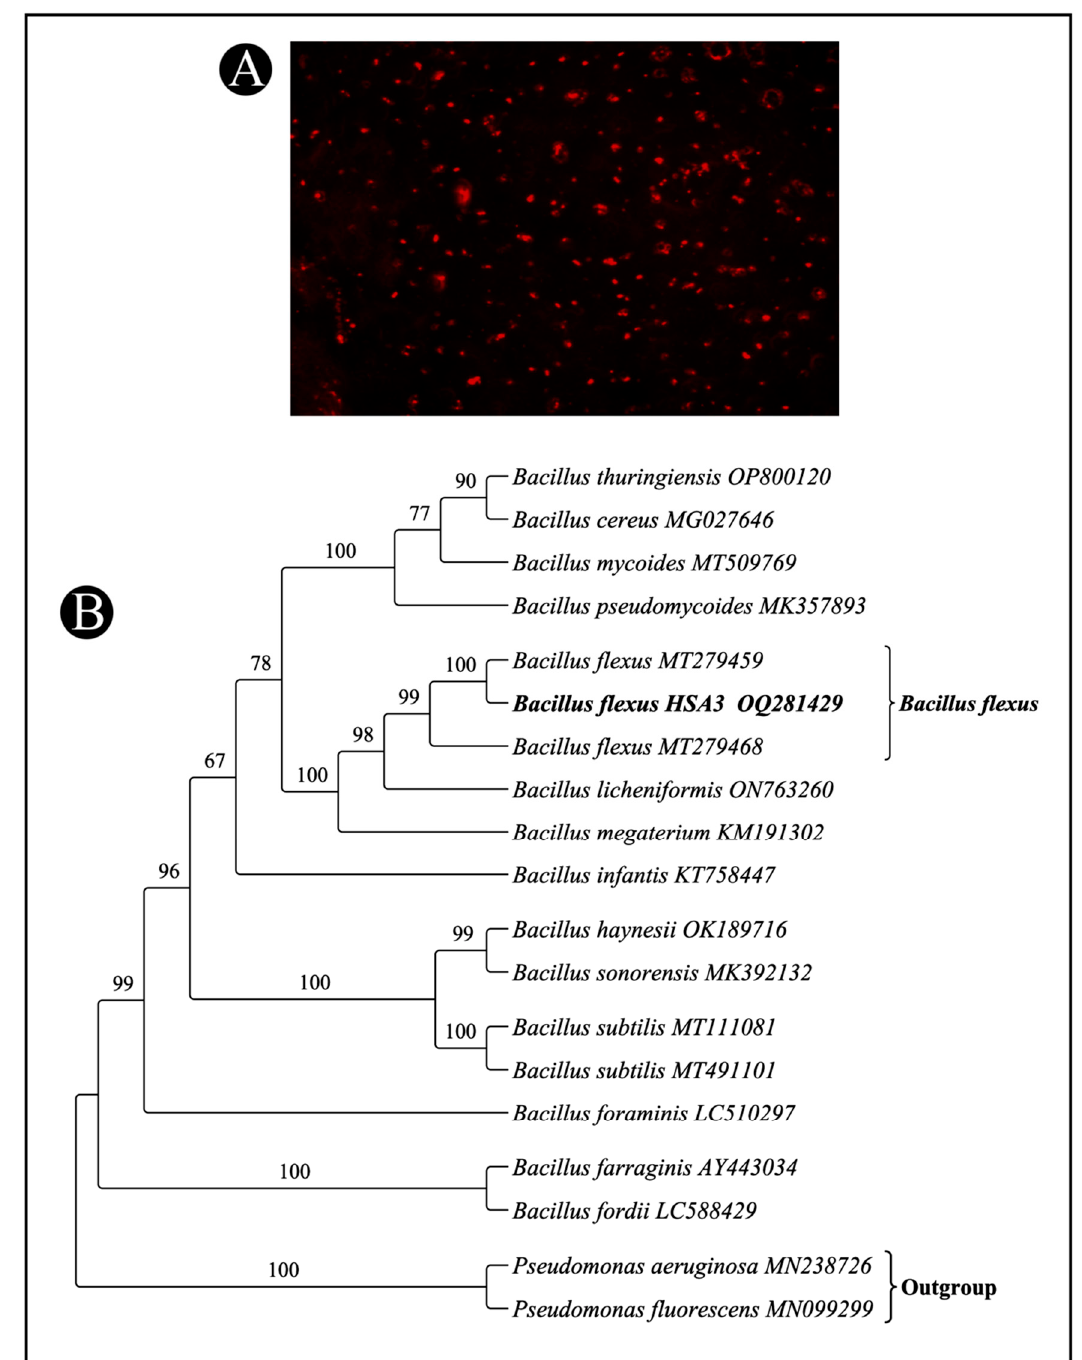
Figure 1. Screening of promising bacterial isolates for PHB production. ( A ) Staining of HSA3 isolates with Nile blue dye as observed under fluorescence microscope ( B ) Phylogenetic tree based on 16S rRNA nucleotide sequences of the bacterial isolates B. flexus strain HSA3 with other sequences of Bacillus strains.